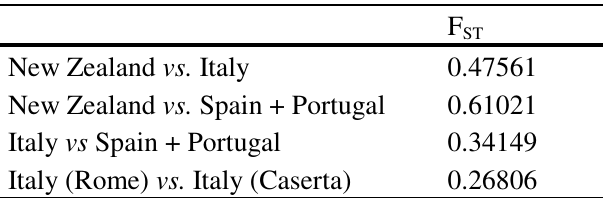
Table 7. Gene flow estimates (F isolated from different geographic